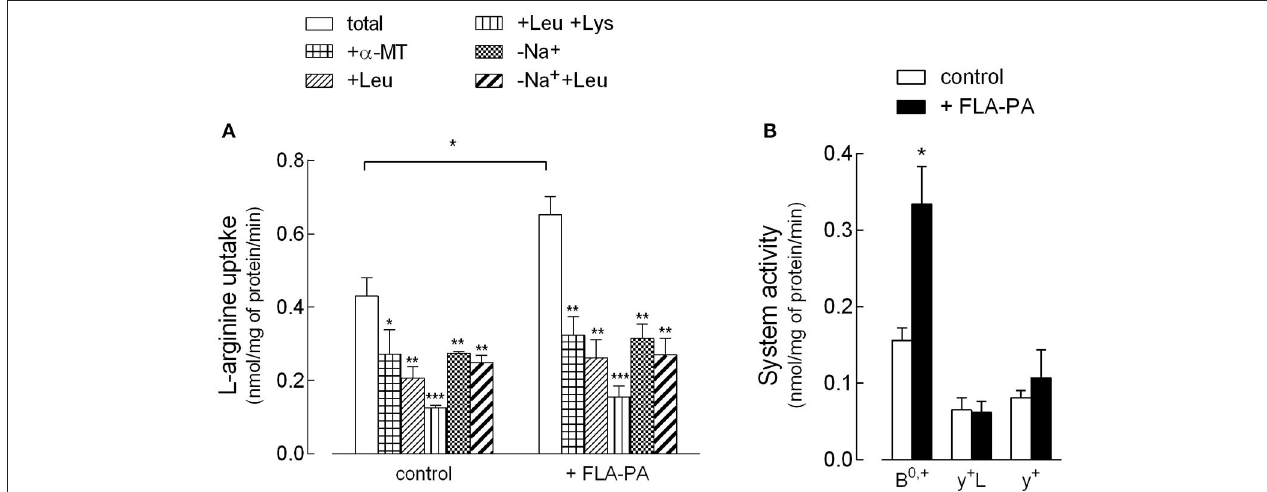
FIGURE 1 | Calu-3 cells were incubated for 8h in the absence (control) or in the presence of 2 µ g/ml flagellin from Psuudomonas aeruginosa (FLA-PA). (A) 30 s-[ 3 H]arginine uptake (50 µ M; 5 µ Ci/ml) was measured both in Na + -containing (total uptake) and Na + -free (-Na + ) Earle’s Balanced Salt Solution (EBSS), in the absence or in the presence of 2mM methyltryptophan ( α -MT), leucine, or leucine and lysine, as indicated. Bars represent the mean ± SEM of three independent determinations. * p < 0.05, ** p < 0.01, *** p < 0.001 vs. total. (B) Data of (A) were employed to calculate the contribution of systems ATB 0, + , y + L, and y + to total uptake as follows: ATB 0, + = Na + -dependent uptake; y + L = “ + Leu uptake” – “ + α -MT uptake”; y + = “ + Leu uptake” – “ + Leu + Lys uptake”. * p < 0.05 vs.